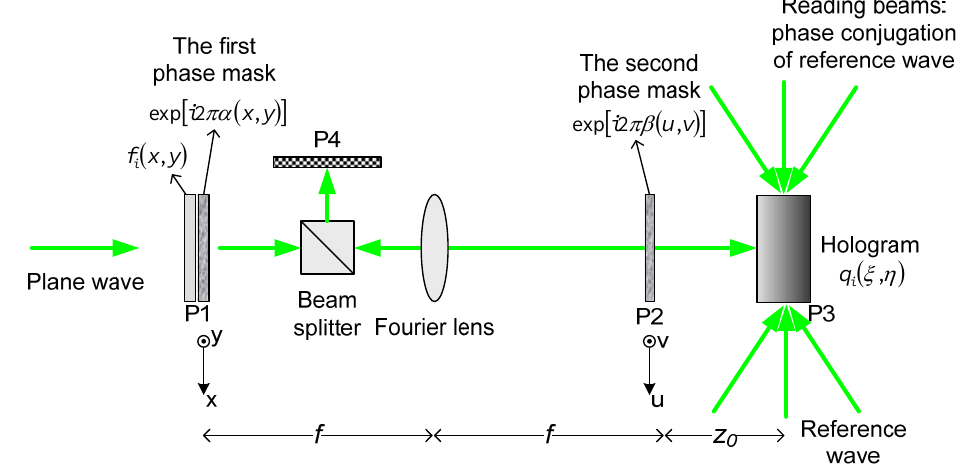
Figure 6. Holographic storage of encrypted image that uses double-random phase